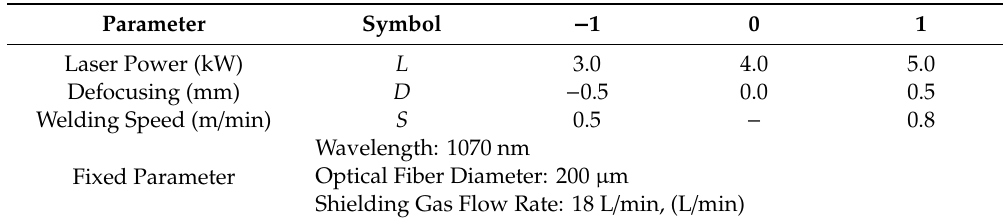
Table 3. Fiber laser welding parameters and their levels.